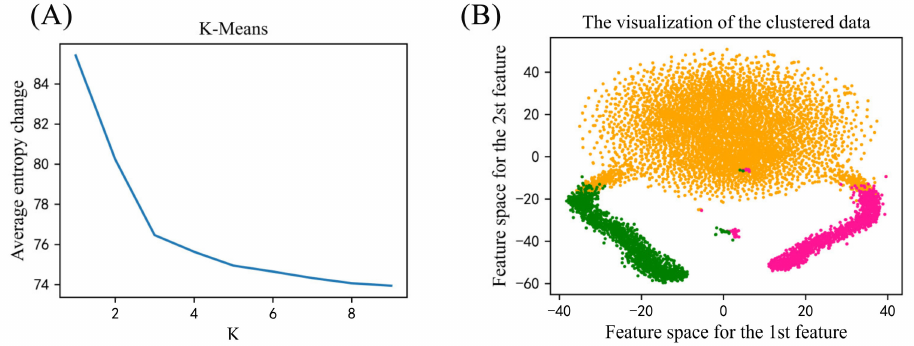
Figure 2. K-means clustering analysis. ( A ) Average entropy changes of different categories. ( B ) The visualization of the clustered